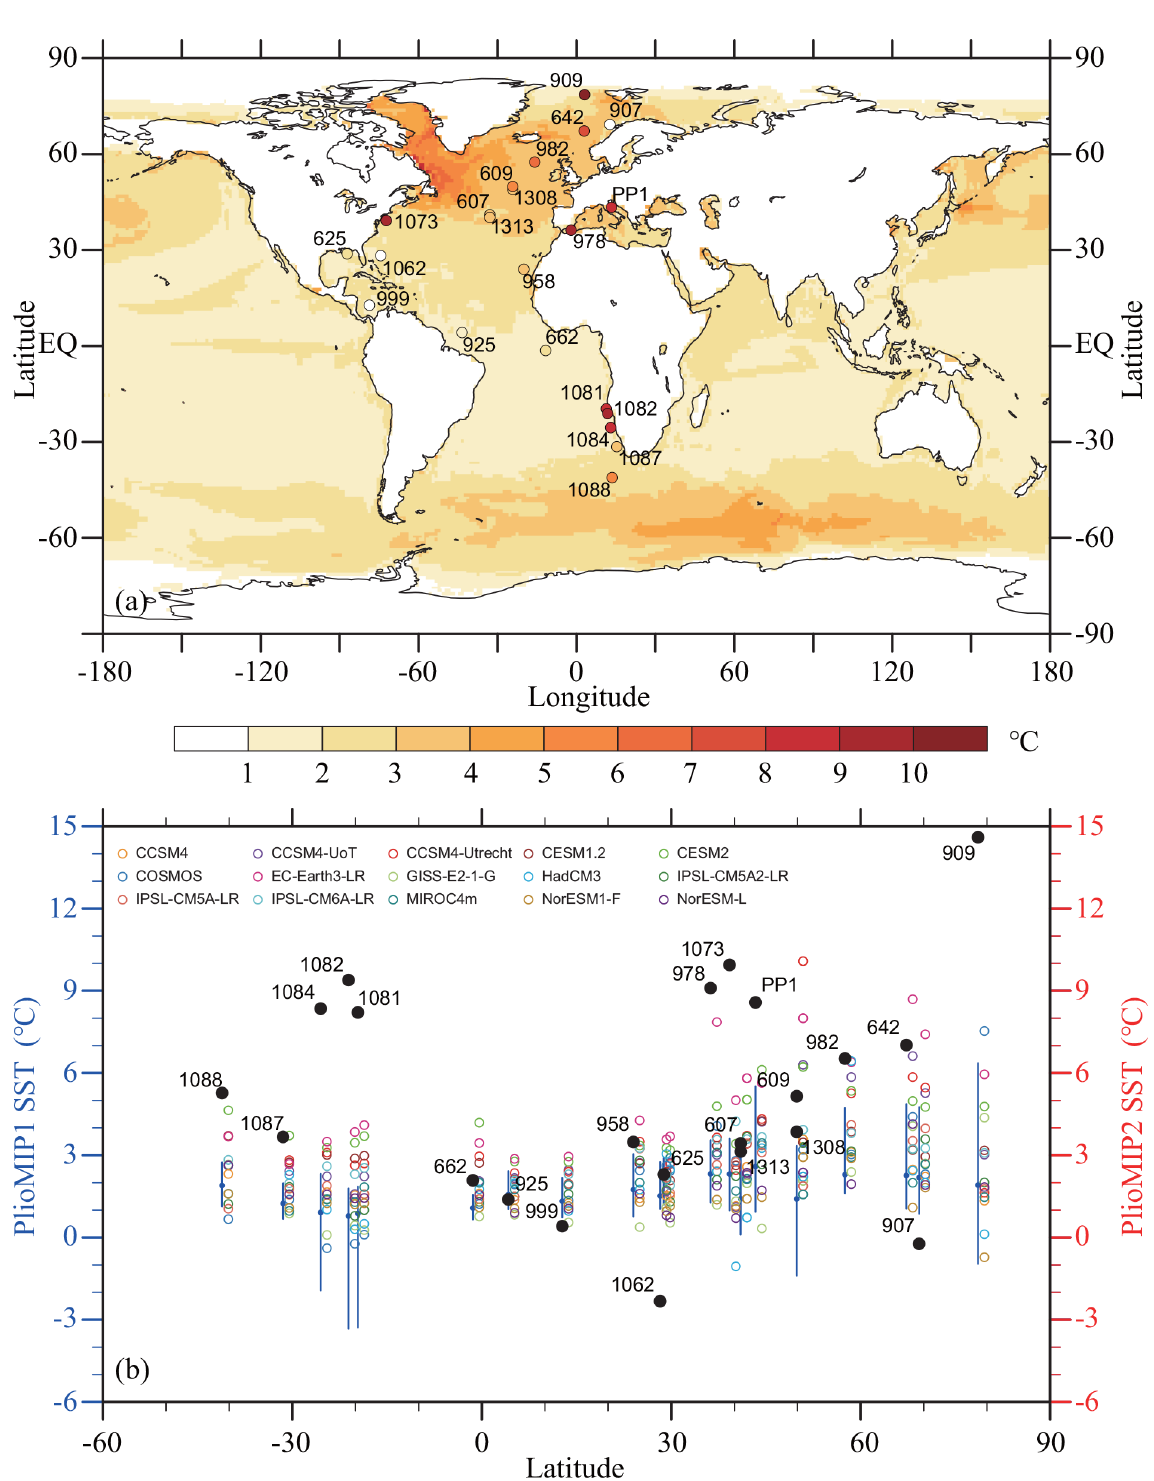
Figure 6. PlioMIP2 and PRISM4 SST comparison in the Atlantic. (a) PRISM4 SST anomalies (points) at data sites in the Atlantic and the Mediterranean plotted against the multi-model ensemble median of SST anomalies (shaded; the mid-Pliocene vs. the pre-industrial) simulated in PlioMIP2 (unit: ◦ C). (b) Black dots show the PRISM4 SST anomalies (unit: ◦ C) at each site. Vertical blue lines and dots show the PlioMIP1 ranges and median values of changes in SST for each site. Coloured markers show SST changes simulated by each model in PlioMIP2. The PRISM4 SST anomalies are calculated based on the PRISM4 mid-Pliocene reconstructions (3.19–3.22Ma; Foley and Dowsett, 2019) and the modern observation (1870–1899; Rayner et al., 2003).